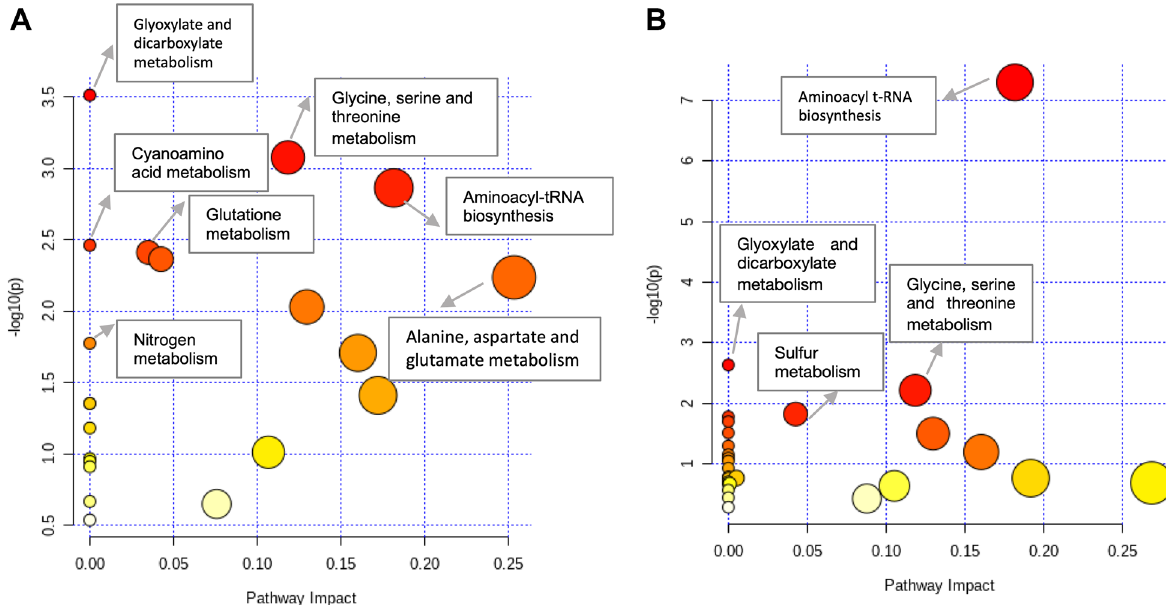
Up-regulated metabolites. ( b ) Down-regulated metabolites. Larger circles, higher and closer to Y-axes, show a higher impact of the concerned pathway of X. citri . Colors indicate different levels of significance. The pathways with P < 0.05 are